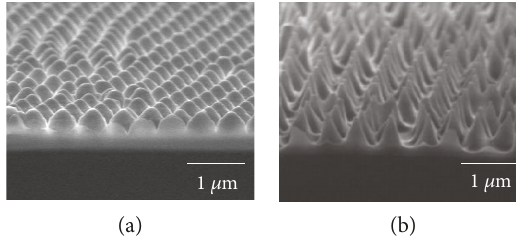
Figure 4: The SEM images of the fabricated NDL with (a) nanodome shape and (b) nanocone